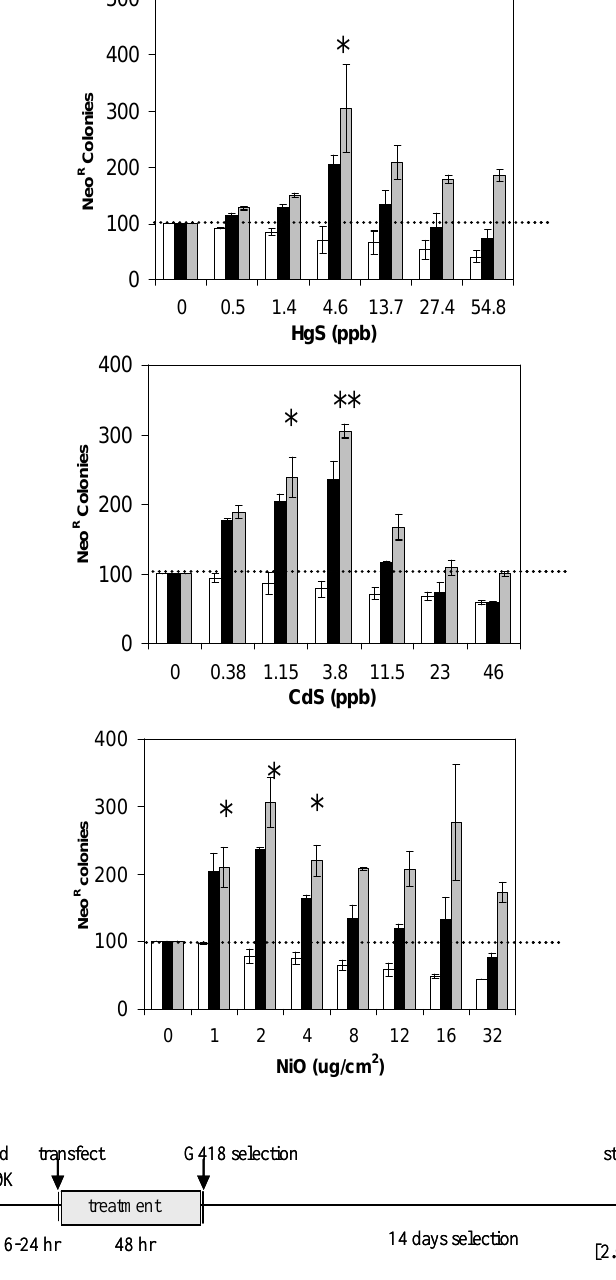
Figure 3: Effect of different compounds on L1 retrotransposition activity (transient transfection Figure 3 Figure 3